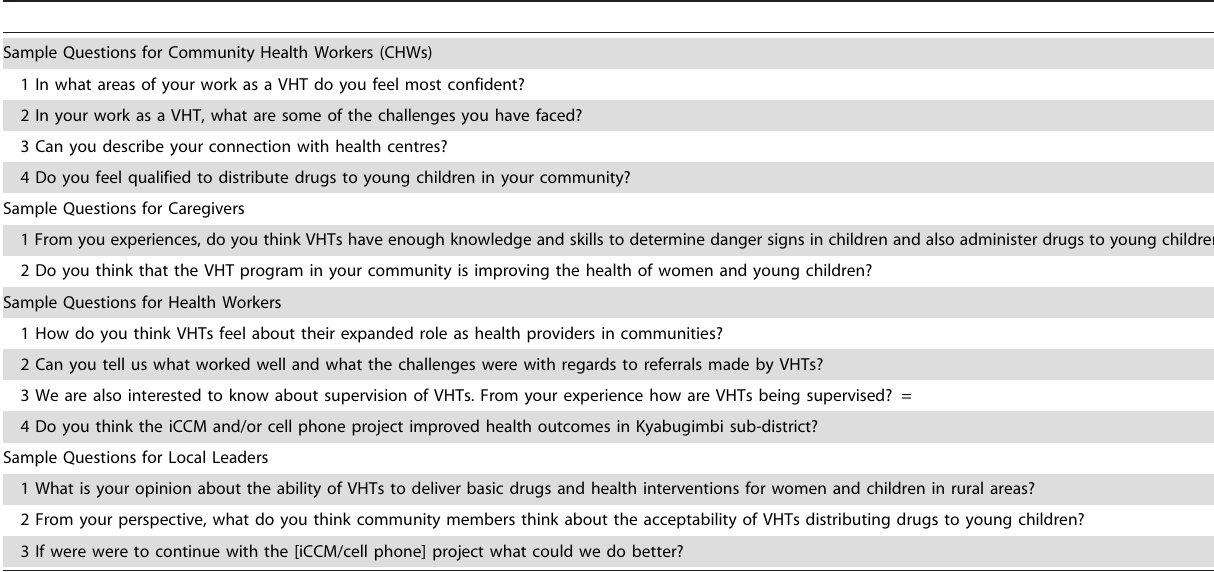
Table 1. Sample of Questions from Focus Group Discussions and Key Informant Interviews.